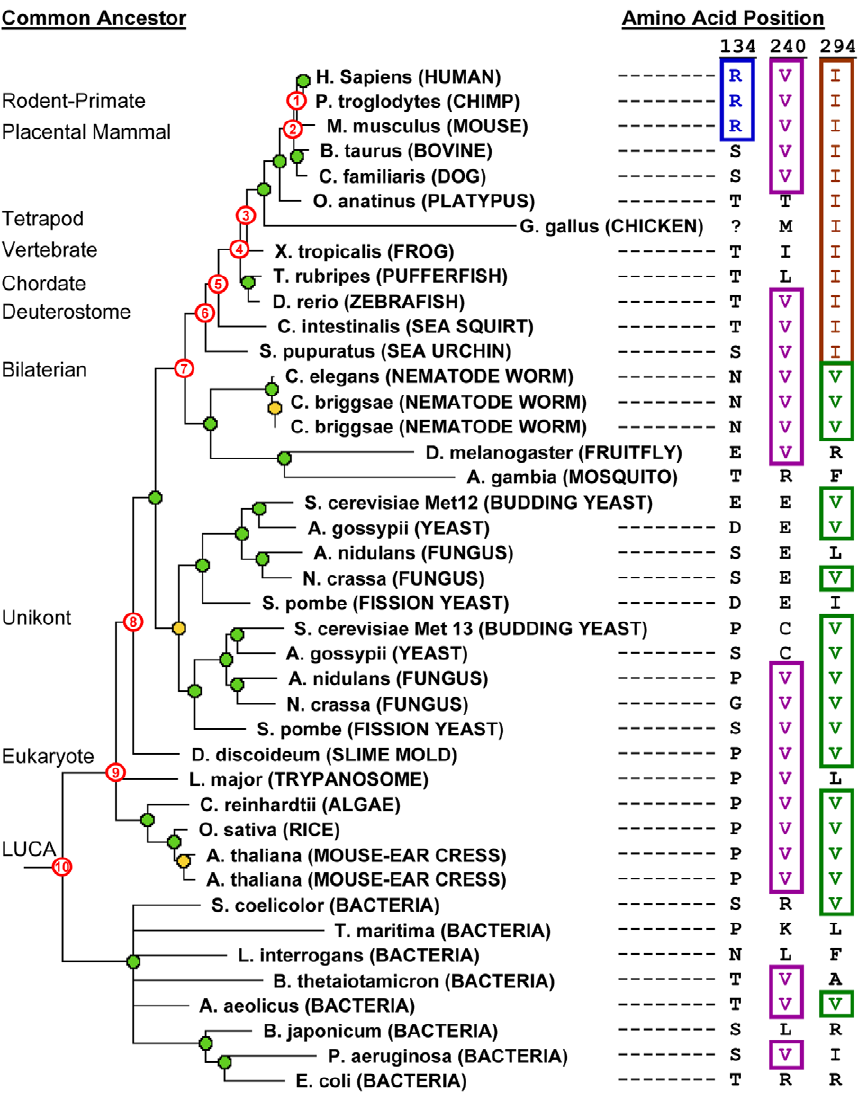
Figure 3. Phylogenetic tree and ancestral allele determination from orthologs of human MTHFR. Tree: MTHFR sequences from modern- day species are indicated. Database identifiers for these entries are listed in Table S2. Gene duplication events are shown with orange circles, and speciation events with green circles. Nodes numbered in red correspond to ancestral branch points in the human MTHFR lineage. Longer branch lengths indicate faster evolutionary rate. The chicken sequence was given an arbitrary, long branch length because it is a sequence fragment and the actual branch length could not be accurately determined. Ancestral allele determinations: The right columns show the amino acids found in the modern-day sequences corresponding to positions 134, 240 and 294 in human MTHFR. These are shown to illustrate how ancestral sites are determined and, consequently, how long the identity of the site in the human enzyme has been preserved in the human lineage (see text for details).